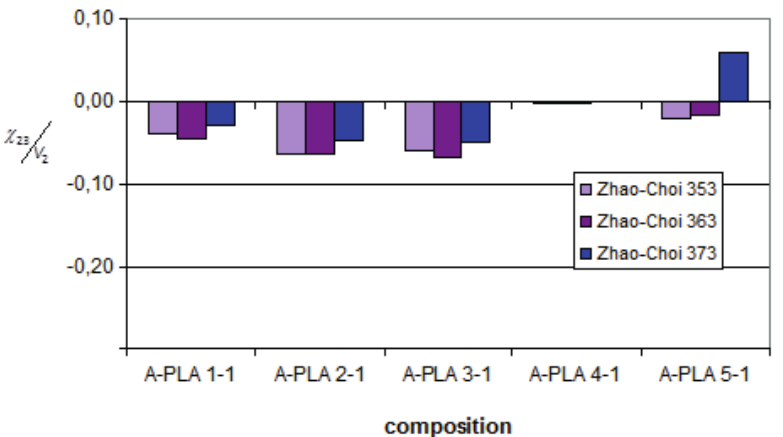
Figure 4: Values of calculated by the Zhao-Choi procedure for Aerosil®200V-PLA compositions (numbers correspond to component weight